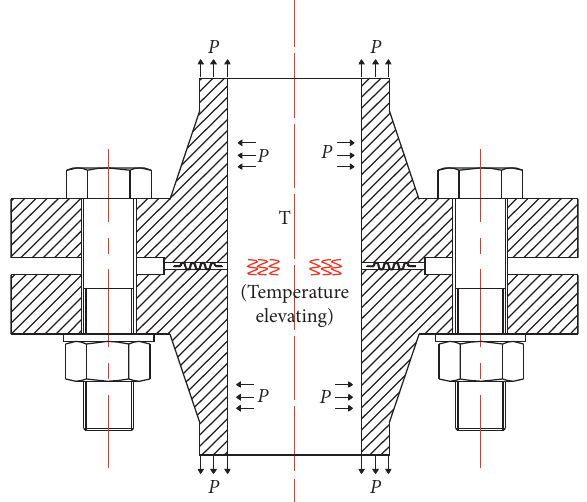
Figure 1: Bolted flange